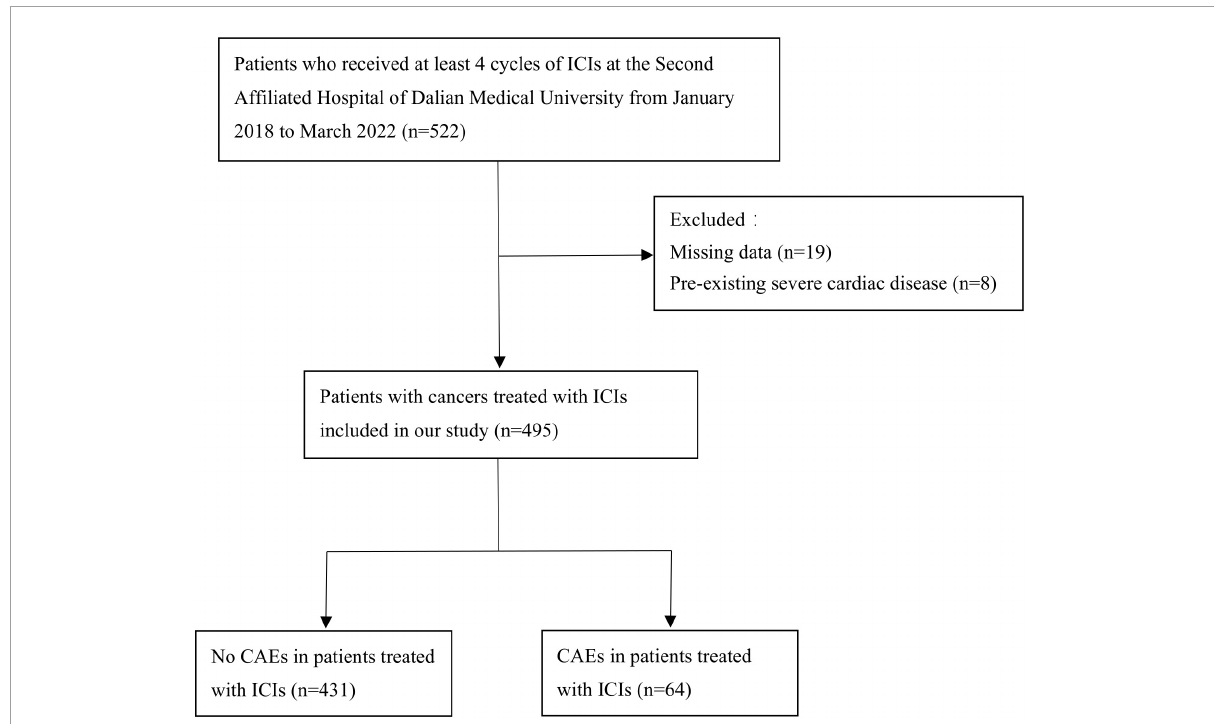
FIGURE1 The study design for retrospective evaluation of CAEs in patients with ICIs. CAE, cardiovascular adverse events; ICI, immune check